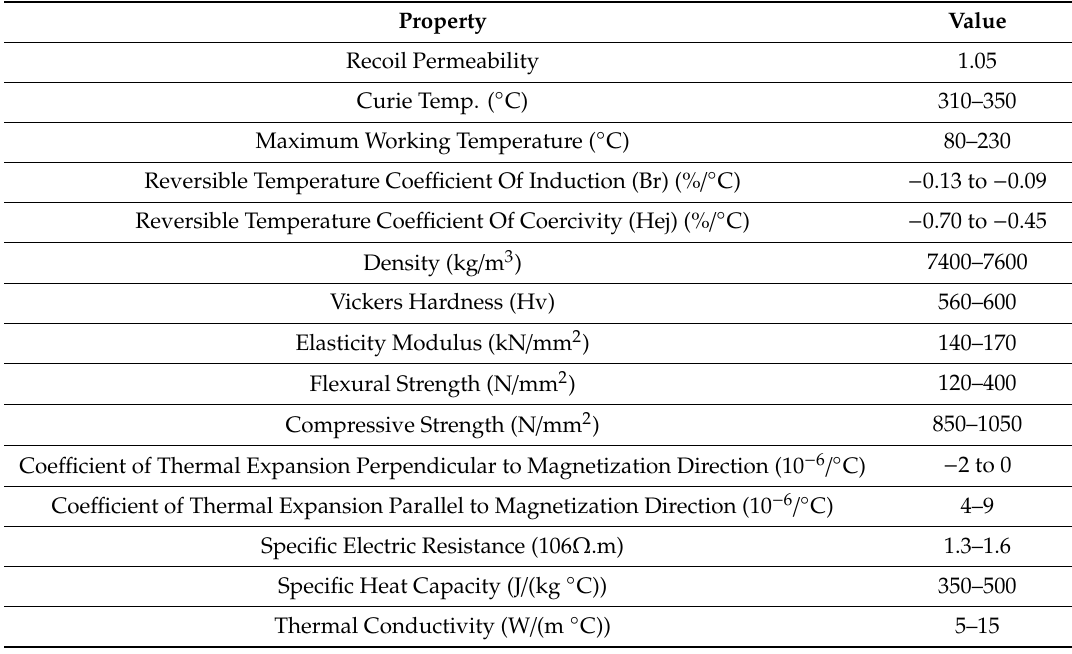
Table 1. Neodymium (NdFeB) magnet properties.